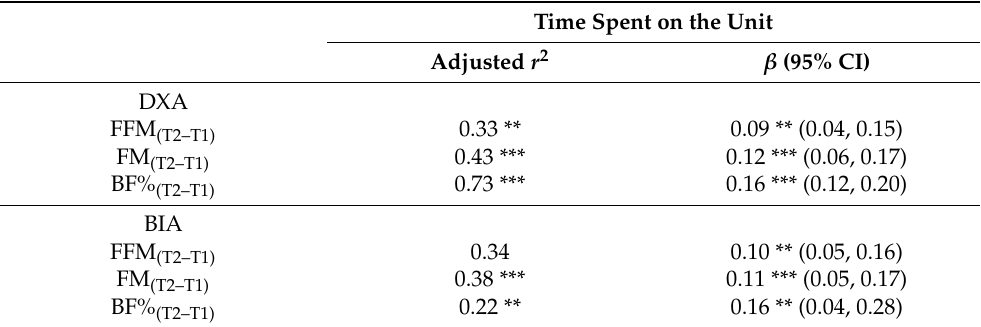
Table 3. Association between time spent on the inpatient specialist unit and the changes in DXA and BIA derived body composition measures from T1 to